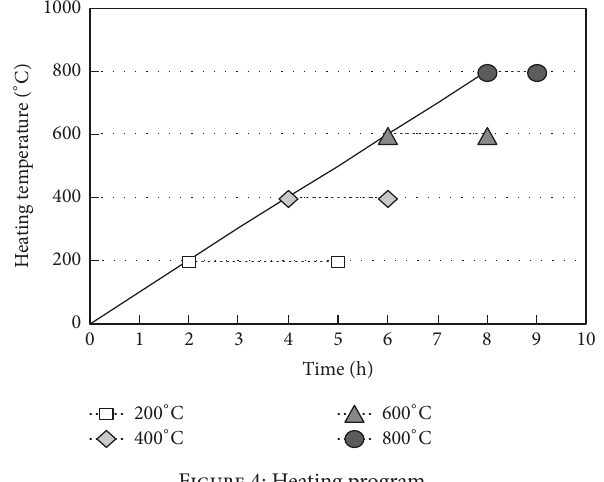
Figure 4: Heating program.